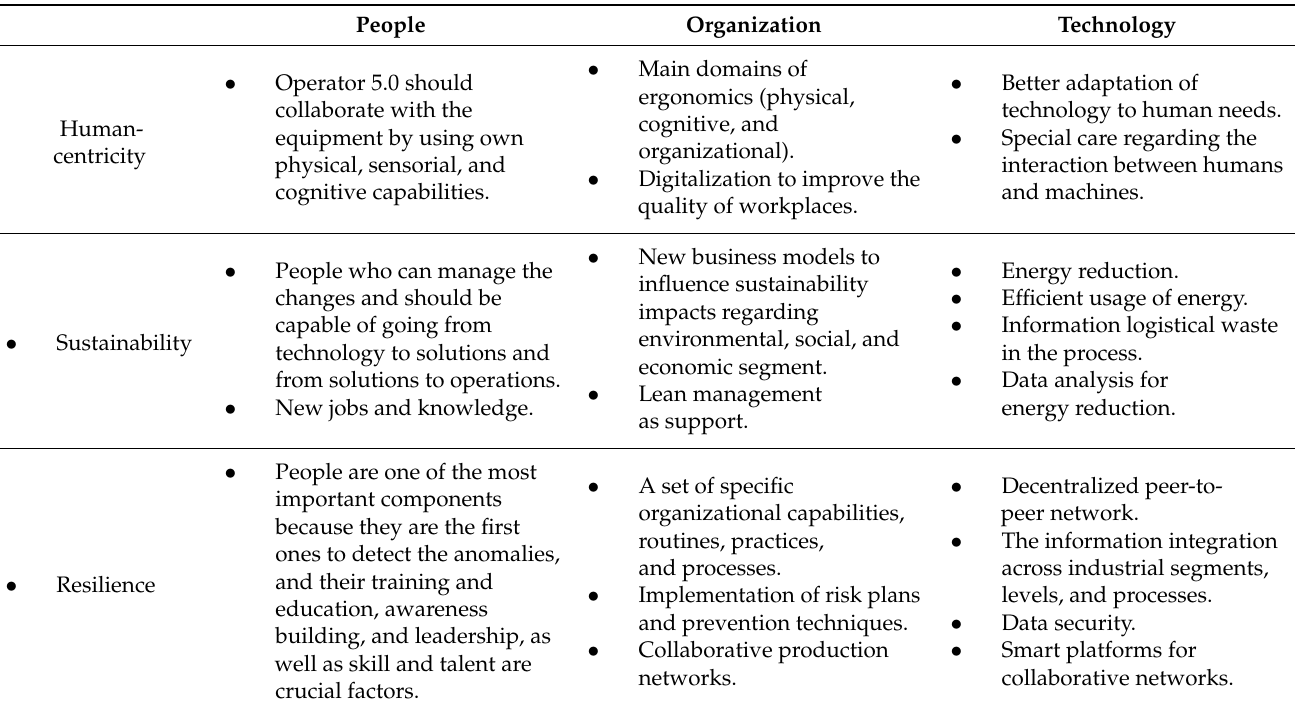
Table 1. The connection between key enablers for Industry 4.0 and Industry 5.0 and people, organiza- tion, and technology in a practical